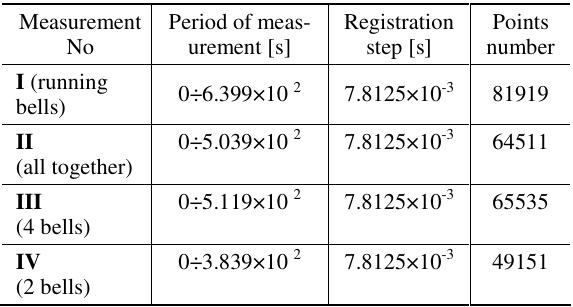
Table 3. The basic data on dynamic measurements